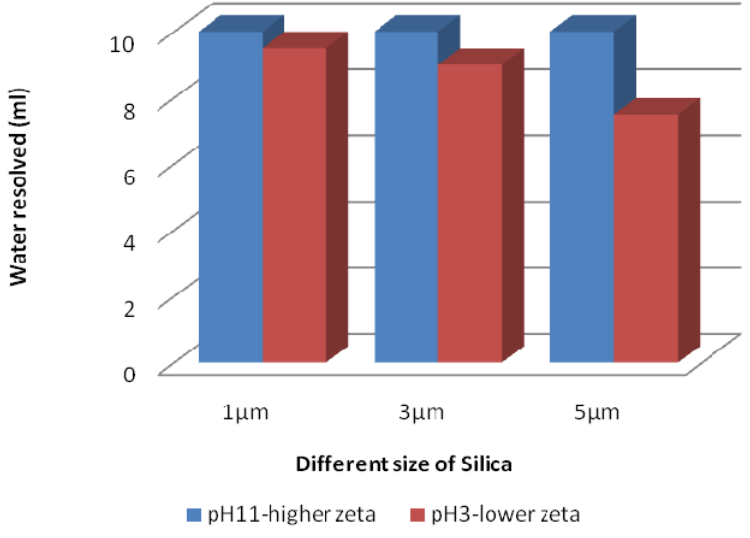
Figure 12. Bottle test results of silica stabilized emulsion at pH~11 and at